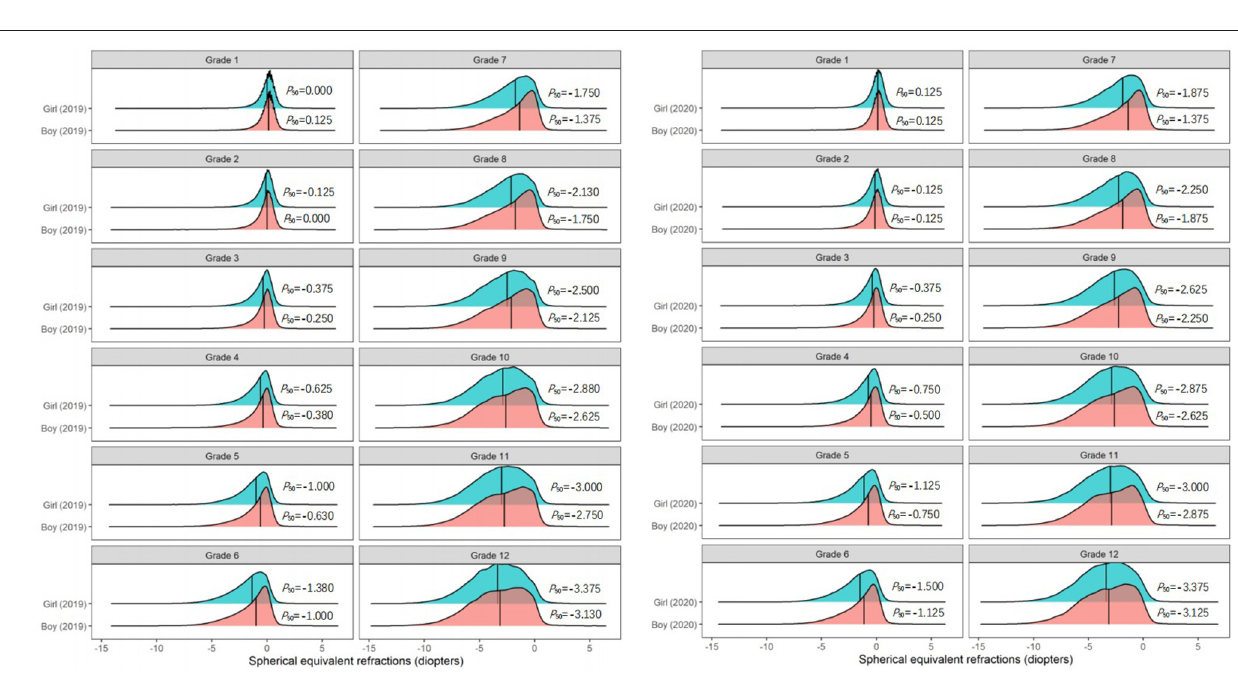
FIGURE 5 | The distribution curves of spherical equivalent refraction among elementary and middle school students in 2019 and 2020 according to